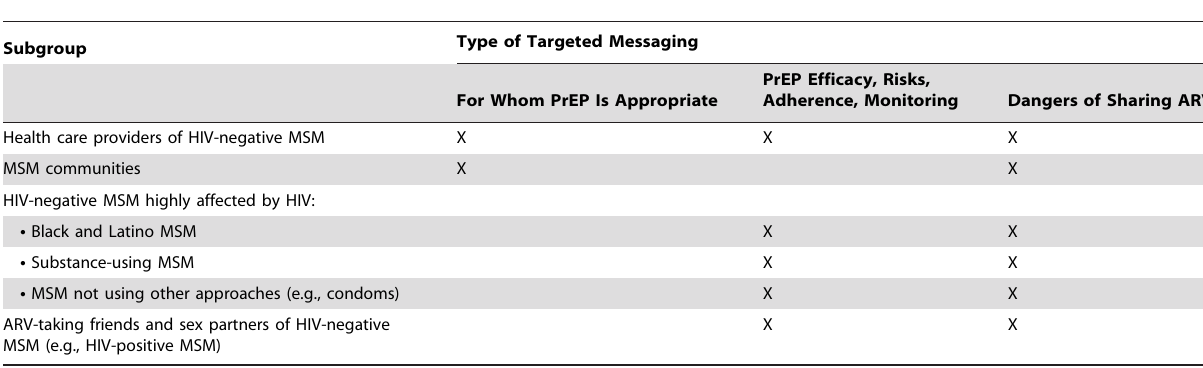
Table 1. Types of targeted PrEP messaging needed for MSM and health care providers by subgroup.